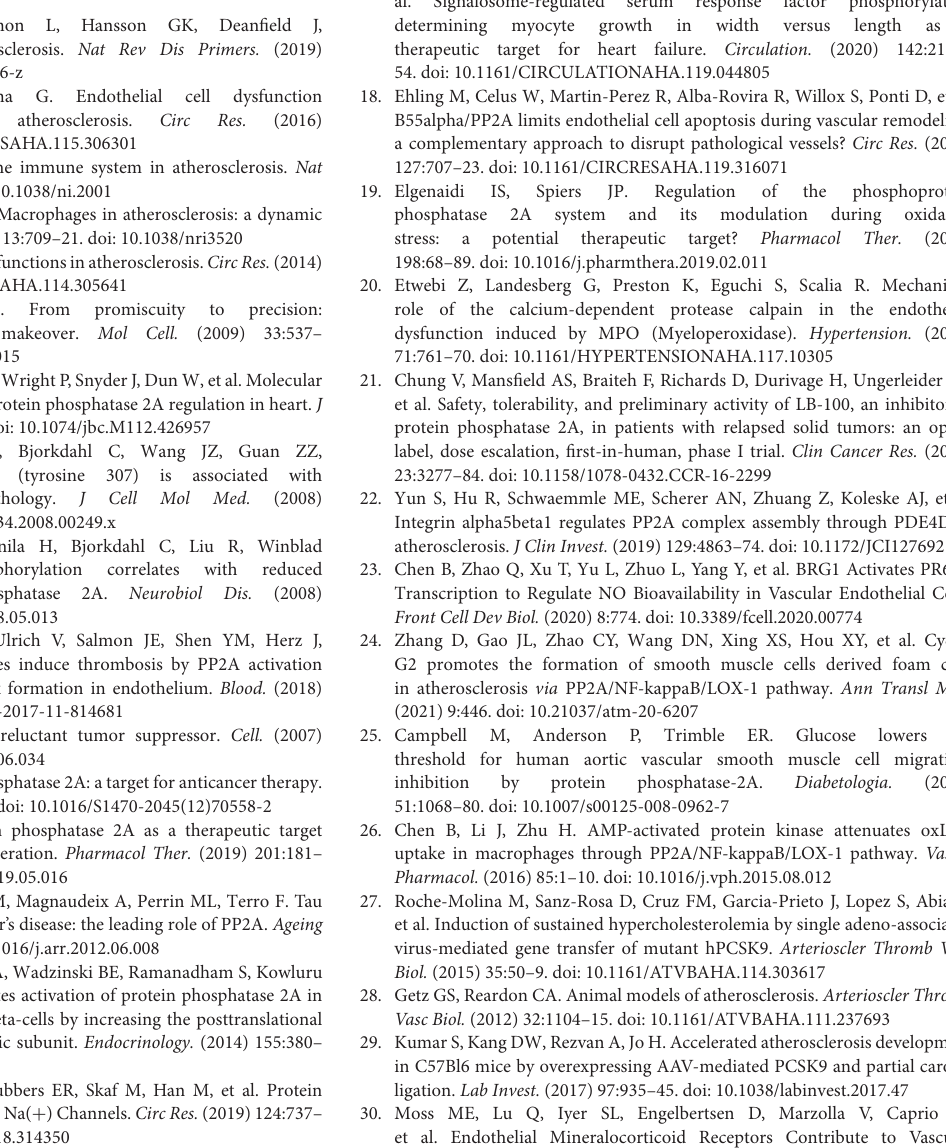
injected with AAV-GFP after 16 weeks of high-fat and high-cholesterol diet feeding. Bar = 2.5mm. (C) The change of body weight during the process of high-fat and high-cholesterol diet feeding in cKO and fl/fl mice injected with AAV-GFP ( n = 7). (D,E) Fasting blood total cholesterol and triglyceride levels after 16 weeks of high-fat and high-cholesterol diet feeding ( n = 7). Supplementary Figure 3 | (A,B) Left panel: foam cell formation in cKO and fl/fl peritoneal macrophages after incubation with oxLDL for 24h. Bar = 100 µ m. Right panel: quantification of foam cell formation (16 sights of each group were selected to conduct the quantitative analysis). Supplementary Figure 4 | (A, B) Left panel: foam cell formation in cKO and fl/fl peritoneal macrophages treated with inhibitors of signaling pathways and oxLDL. Bar = 100 µ m. Right panel: quantification of foam cell formation (16 sights of each group were selected to conduct the quantitative